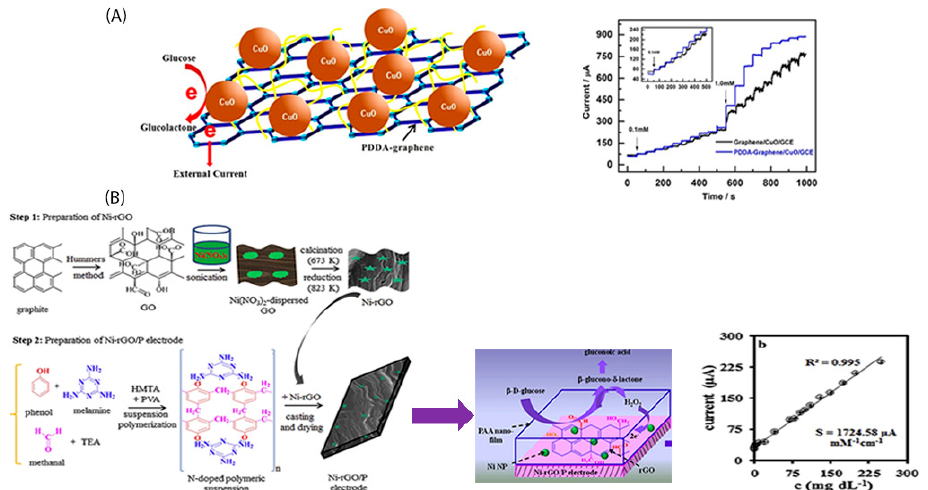
Figure 4. ( A ) Poly-(dimethyl diallyl ammonium chloride (PDDA) functionalized graphene decorated with CuO nanoparticles and its respective amperometric response to glucose injection [87]; and ( B ) PAA covered Ni-rGO synthesis procedure (left) and its respective amperometric response to glucose injection [90].